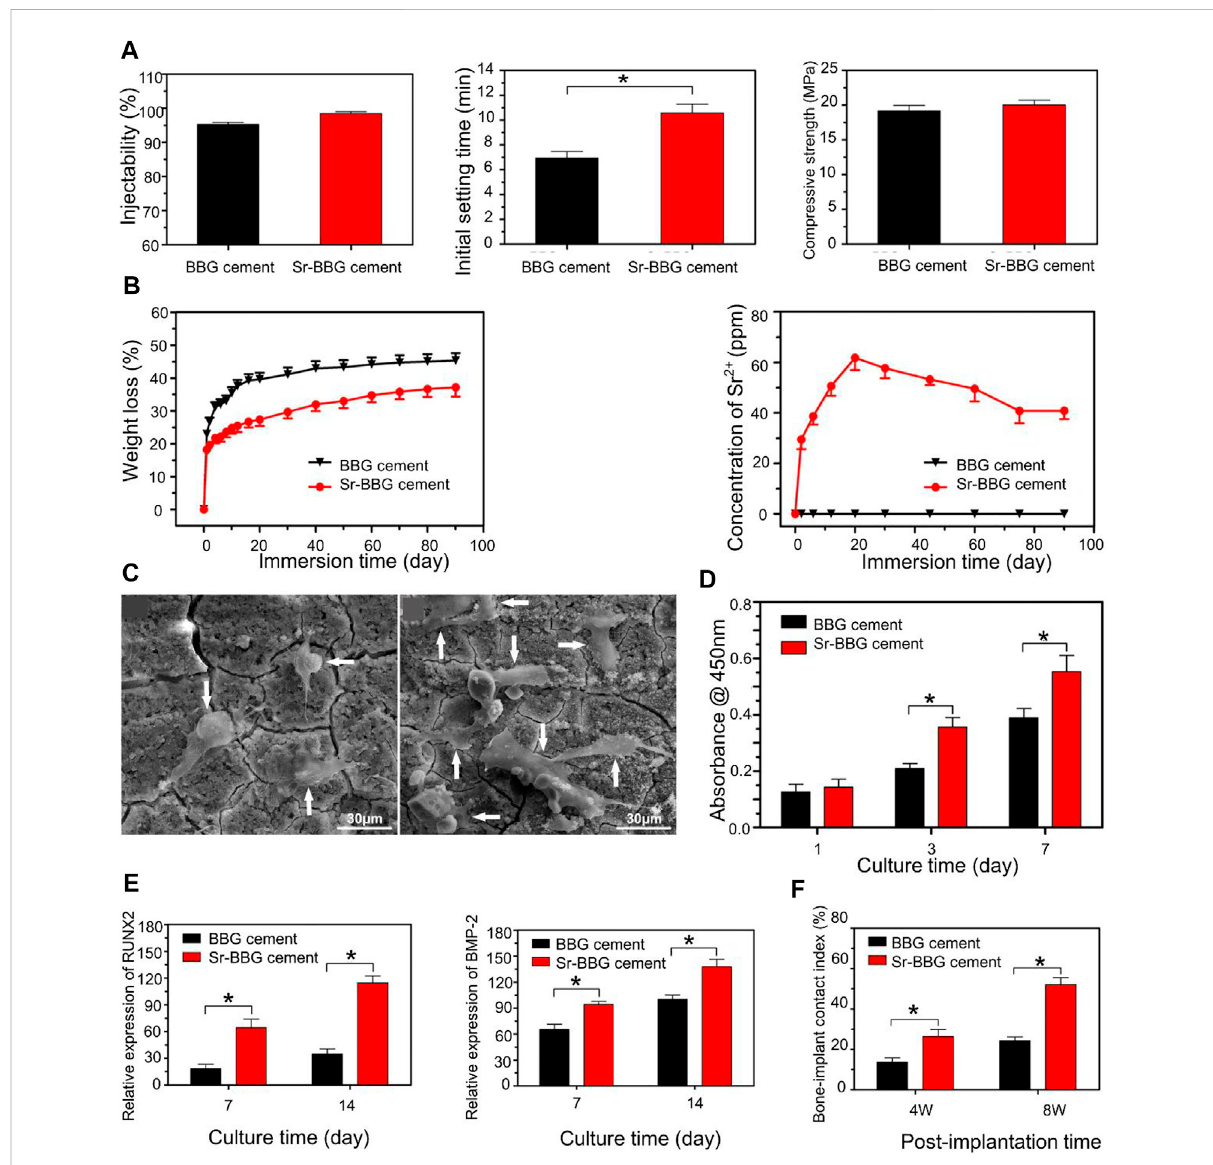
FIGURE 5 (A) Physical properties of BBG and Sr-BBG cements: injectability, initial setting time, and compressive strength. (B) Weight loss of BBG and Sr- BBG cement, and the amount of Sr 2+ ions released from the Sr-BBG cement into the SBF. (C) SEM images showing the attachment of human bone marrow-derived mesenchymal stem cells (hBMSCs) on BBG and Sr-BBG cement after culturing for 3 days. (D) CCK8 proliferation experiments on days 1, 3, and 7: hBMSCs cultured on BBG and Sr-BBG cement. (E) The expression levels of osteogenic differentiation-related genes were measuredon days7and14. (F) Newlyformedbone andbone-implantcontact(BIC)indexofBBGand Sr-BBGcementimplantedat4and8 weeksin critical-sized rabbit femoral condyle defects. Reproduced with permission from (Zhang et al.,